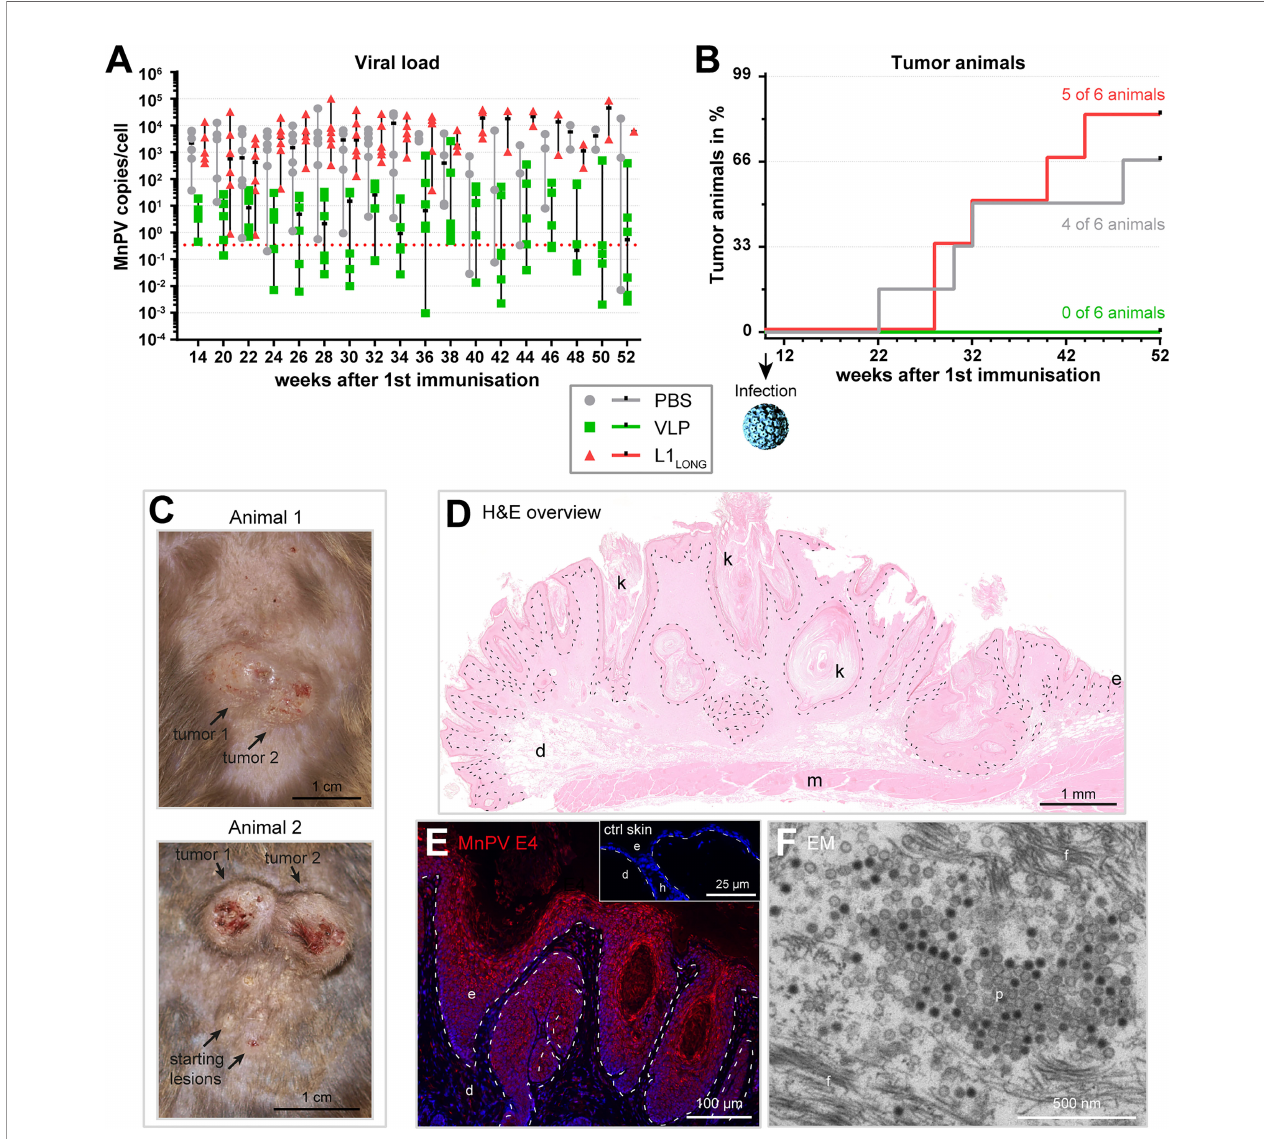
FIGURE 5 | Vaccination with L1 LONG does not prevent viral accumulation and tumor formation after experimental infection. (A) The viral load of the vaccination groups was followed over time via qPCR of DNA extracted from plugged hair. The dashed line represents the methods ’ cut-off based on hair extracted prior to the experimental infection (0.346 MnPV copies/cell). (B) Appearance of tumor-bearing animals in the different vaccination groups (median PBS group: 40 weeks, median L1 LONG group: 36 weeks; PBS vs . VLP: p = 0.0183; L1 LONG vs . VLP: p = 0.0041; log-Rank test). (C) Representative examples of MnPV-induced skin tumors after experimental infection. (D) H&E staining of a MnPV-induced papilloma (animal 1, tumor 2). (E) Immuno fl uorescence staining against the MnPV E4 protein in the epidermal part of same papilloma. The inset shows an E4 stained virus-free skin as negative control. (F) Electron micrograph of virus progeny located in the stratum corneum of a MnPV-induced papilloma (f: fi laments, d: dermis, e: epidermis, h: hair follicle, k: keratinized material, m: muscle, p: